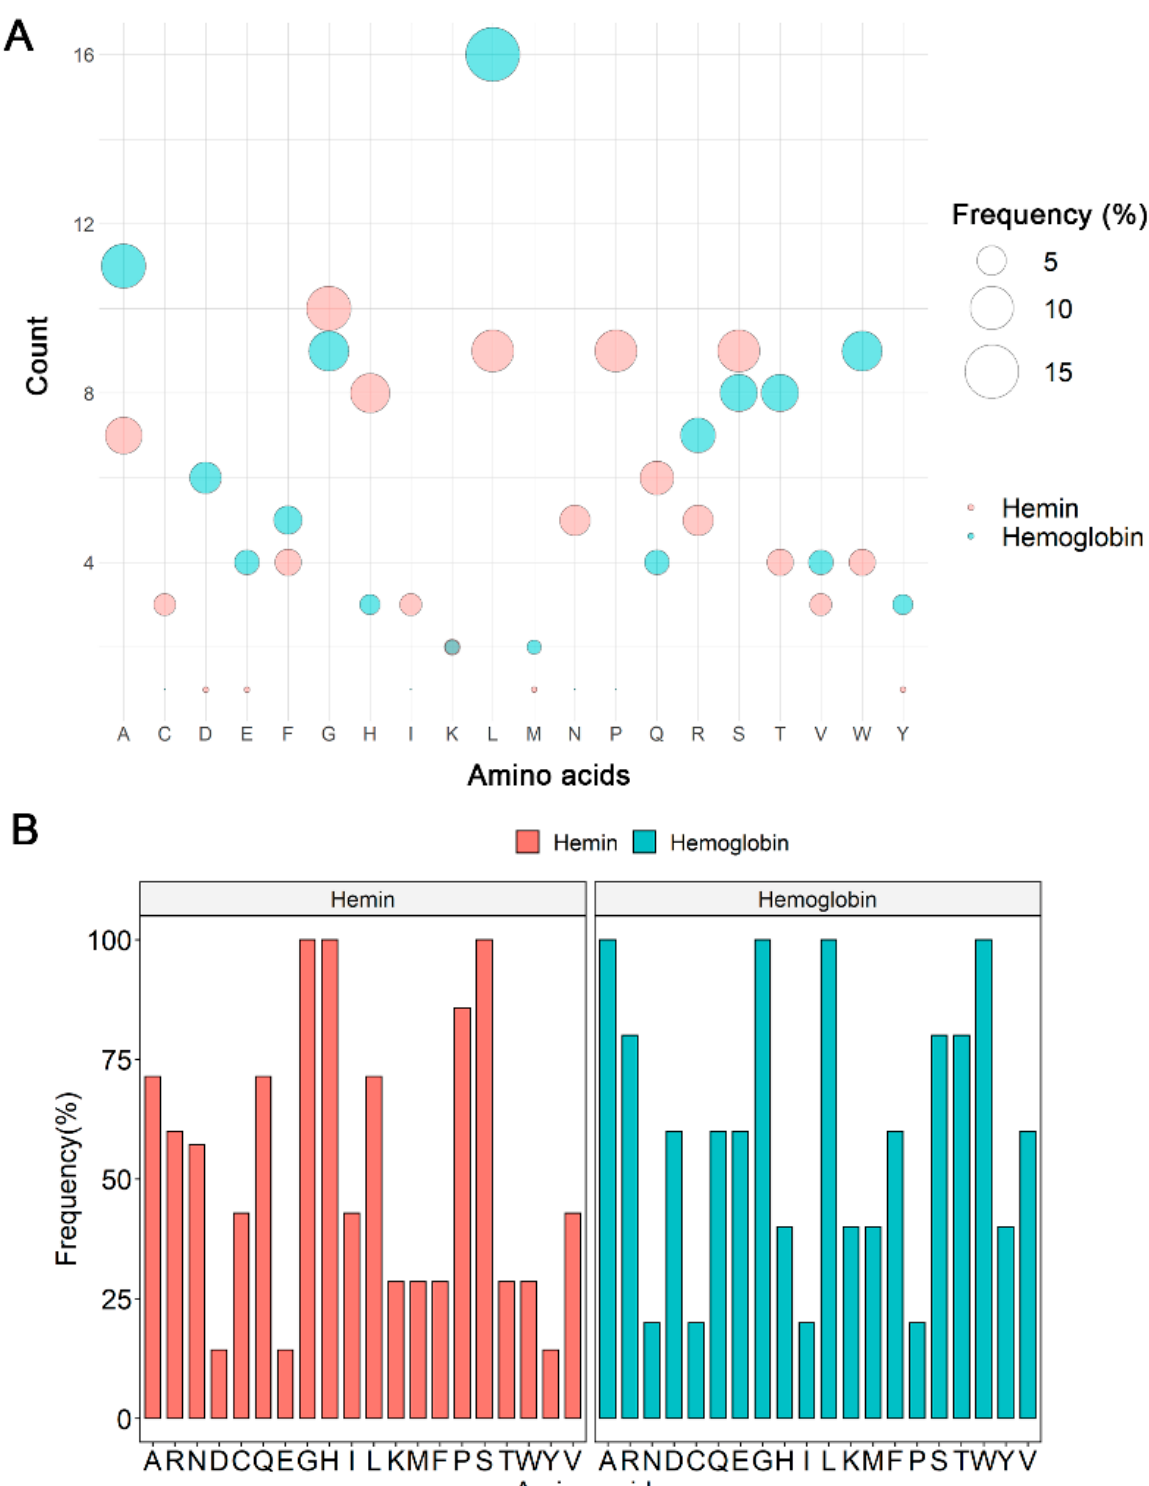
Figure 3. Frequency analysis of the amino acid compositions at Hx interaction sites with hemoglobin and hemin. ( A ) Global counts and frequencies of amino acids in identified Hx sequences. ( B ) Frequencies of amino acids at Hx interaction sites (H1–H7 and Hb1–Hb5).